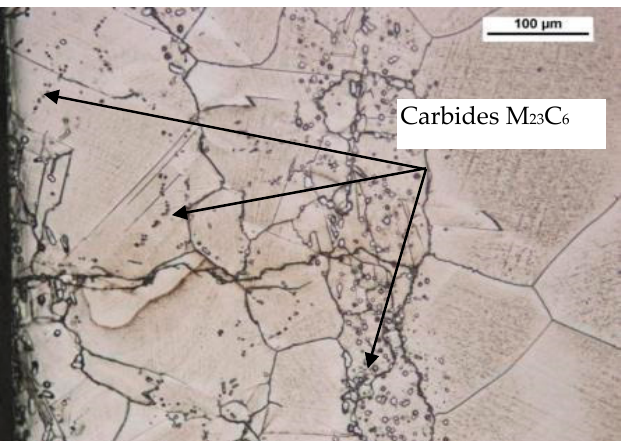
Figure 9. Microstructure of the HR6W alloy. Light microscopy Mi30Fe, a sample material subjected to a total strain of 0.7% at 650 °C, was etched.